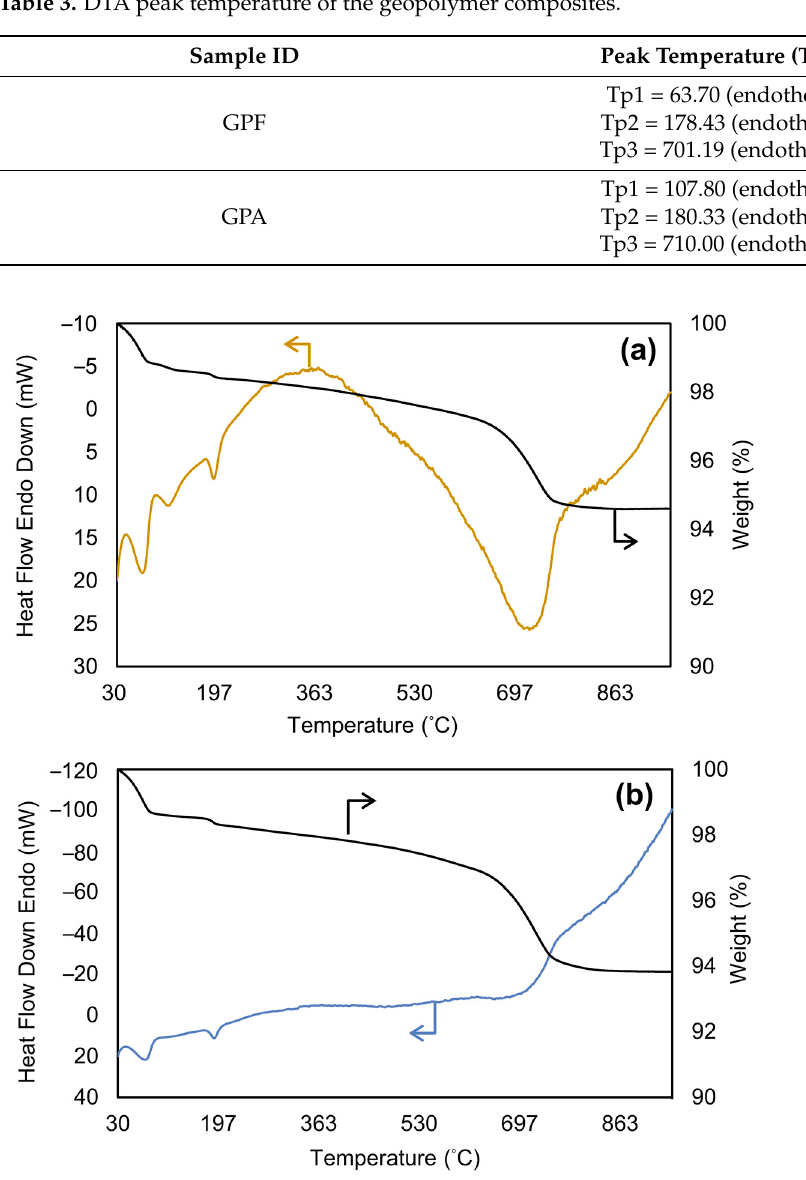
Figure 10. TG-DTA curve with DTA for ( a ) GPA (without POFA) and ( b ) GPF (with POFA). Table 3. DTA peak temperature of the geopolymer